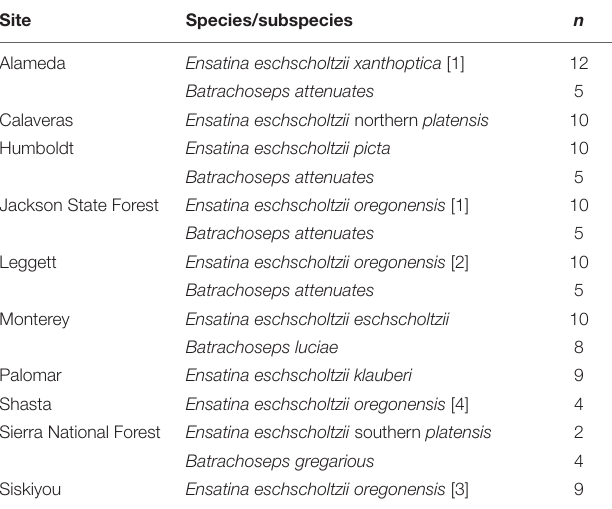
TABLE 1 | Sample sizes ( n ) for each Batrachoseps species and Ensatina subspecies by site.